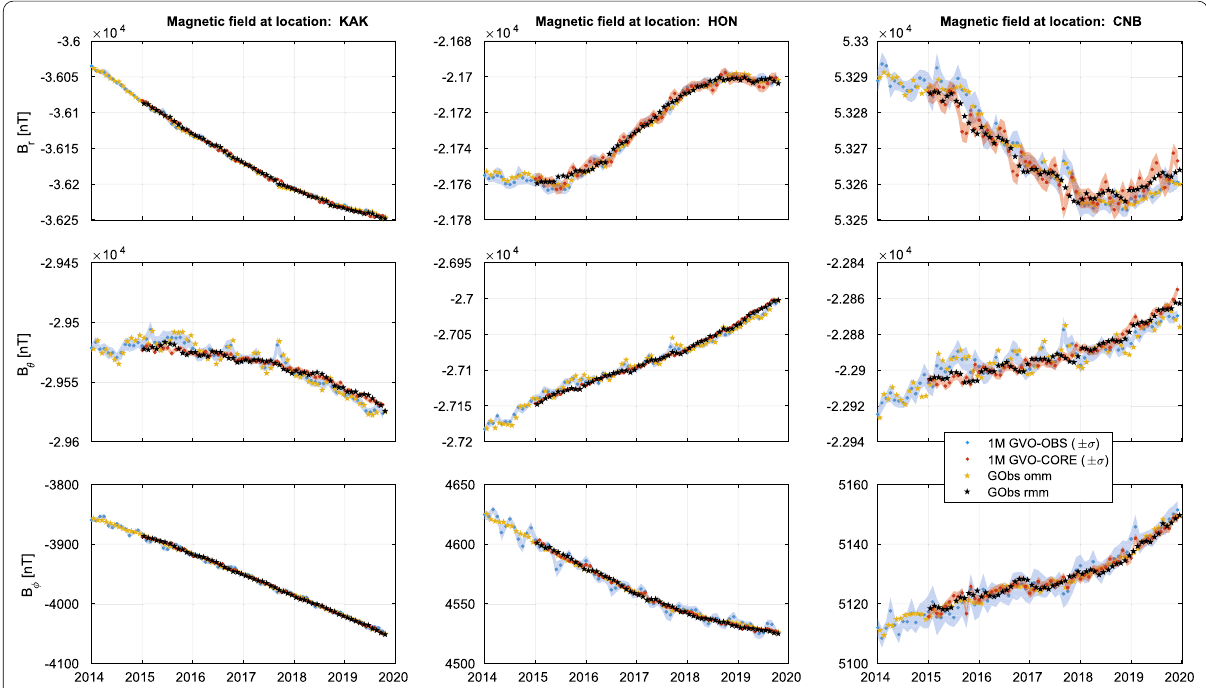
σ uncertainty envolopes, ±